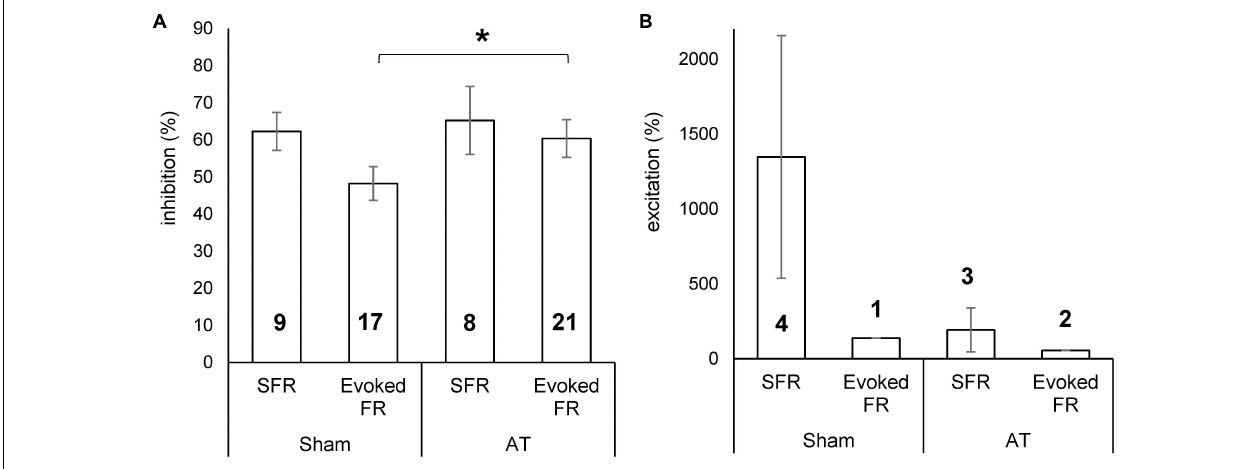
FIGURE 7 | Bar diagrams showing percentage inhibition (A) and percentage excitation (B) on spontaneous firing rate (SFR) and sound evoked FR in sham and AT animals. Data Mean ± SEM. * p < 0.05. Numbers in bars represent number of neurons in which effect was demonstrated.